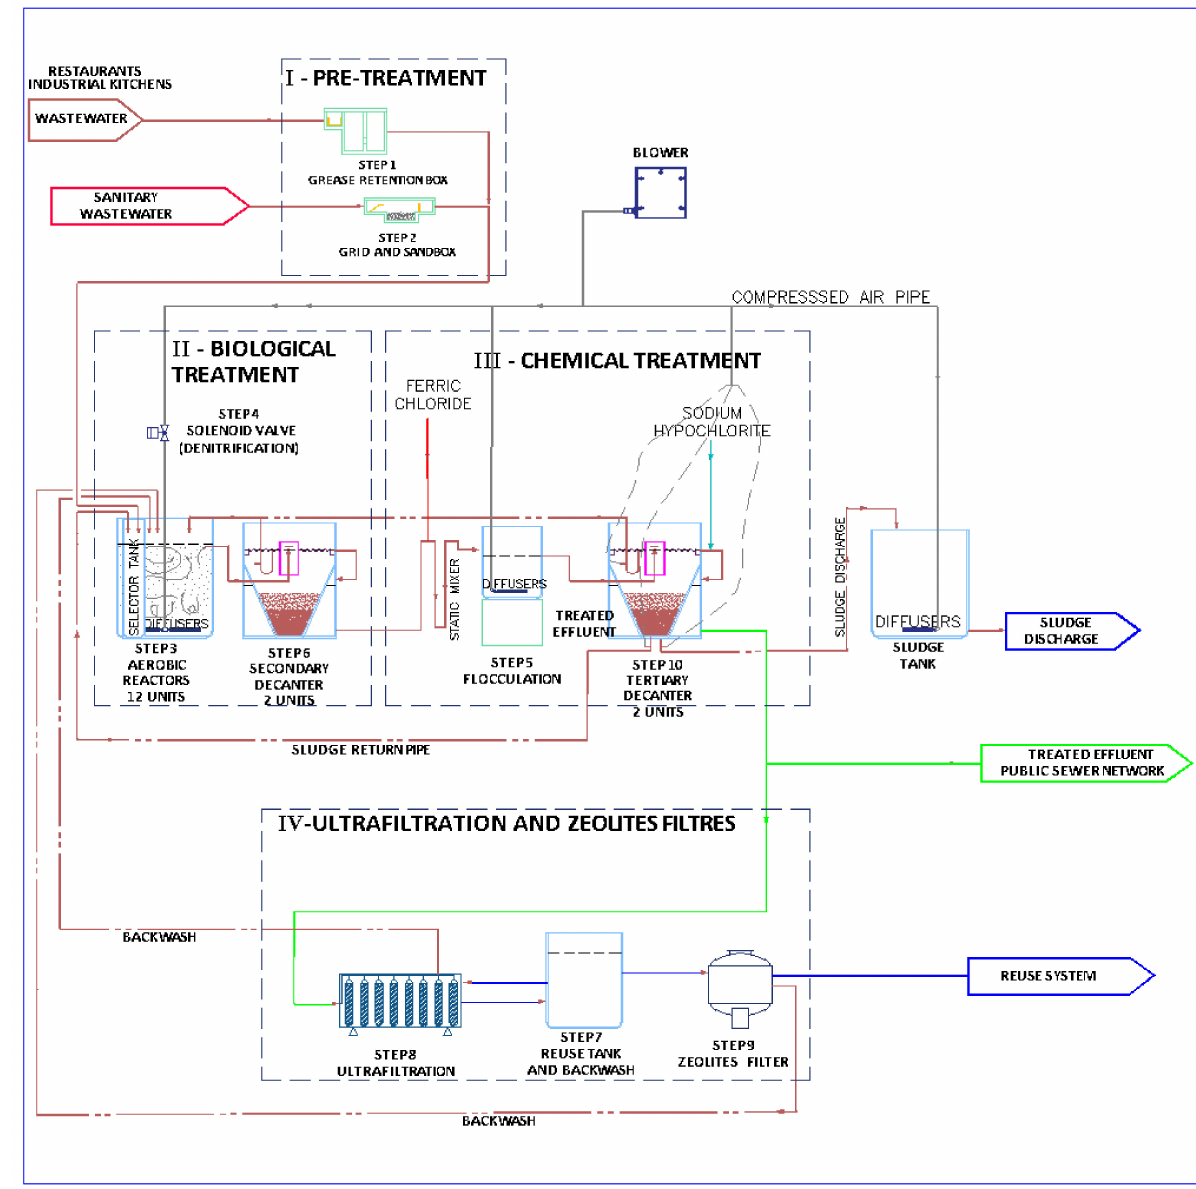
Figure 2. Schematic diagram of the wastewater treatment plant (WWTP) with 10 steps: 1-grid and sandbox; 2-oil and grease retention box; 3-aerobic reactors; 4-denitrification; 5-flocculation; 6-decanting, 7-disinfection; 8-ultrafiltration; 9-filtration by zeolites and 10-tertiary